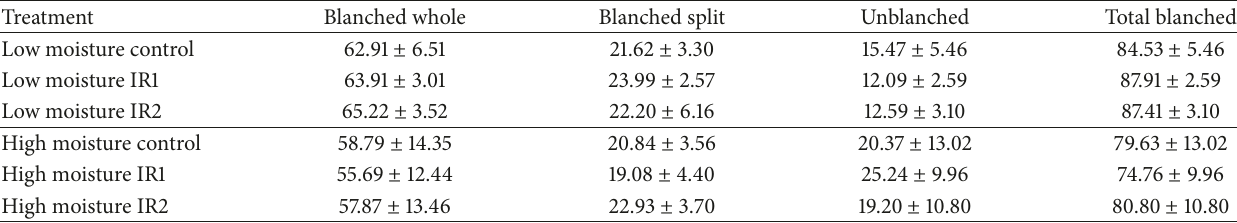
Table 4: Blanching results (%) for the treatment combinations used in this study.